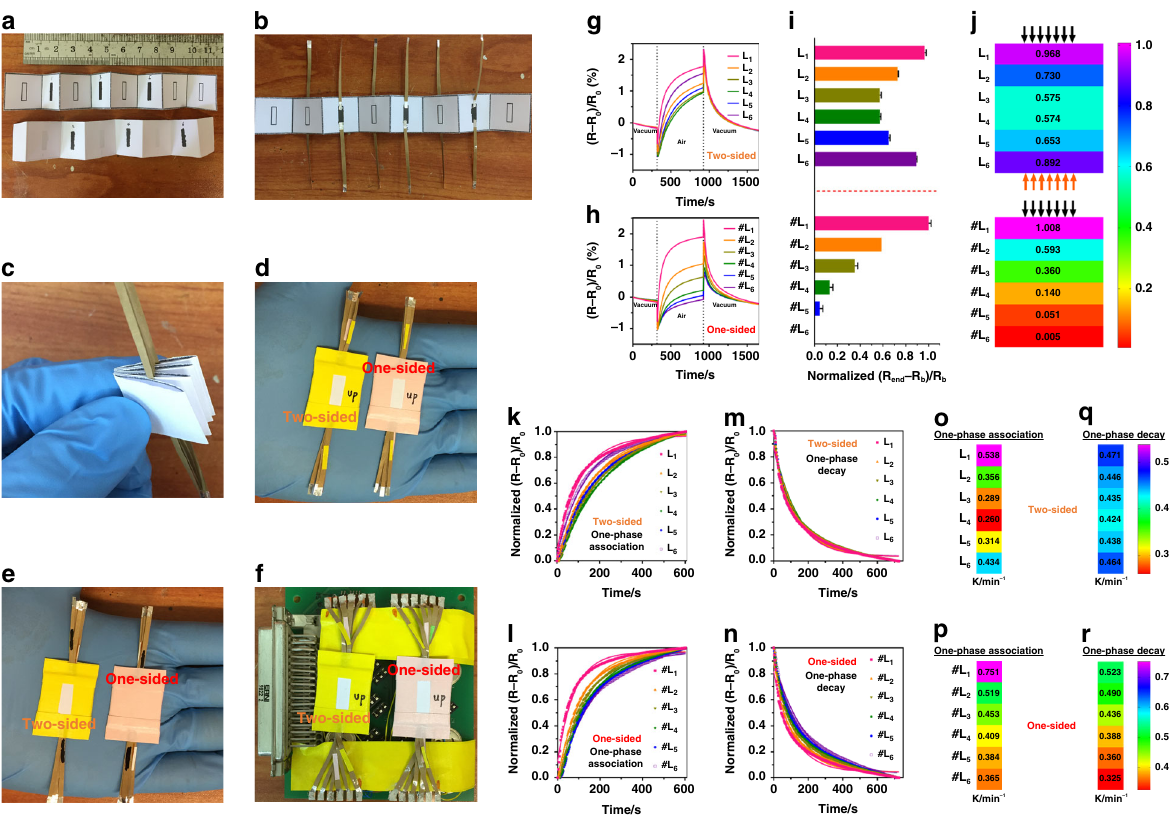
Fig. 2 Devising and characterization of P/G ink-based origami hierarchical sensors array (OHSA). a – f Images describing the design of six-channel OHSA by one P/G ink integrated on a folding paper. g , h Time-course monitoring of the resistance responses in two-sided OHSA and one-sided OHSA upon alternately exposed to a vacuum and air. i , j Bars and color maps represent the layer-dependent ( R end − R b )/ R b responses of two-sided OHSA and one-sided OHSA to air exposure in the two models, respectively. Data are presented as the mean ± SD. Kinetic analysis of the resistance responses of two-sided OHSA ( k , m ) and one-sided OHSA ( l , n ) to air exposure and vacuum clean, respectively. Color maps represent the layer-dependent rate constants ( K ) of two-sided OHSA ( o , q ) and one-sided OHSA ( p , r ) to air exposure and vacuum clean,